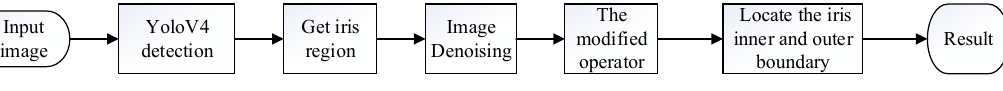
Figure 2. Flow chart of the localization algorithm.